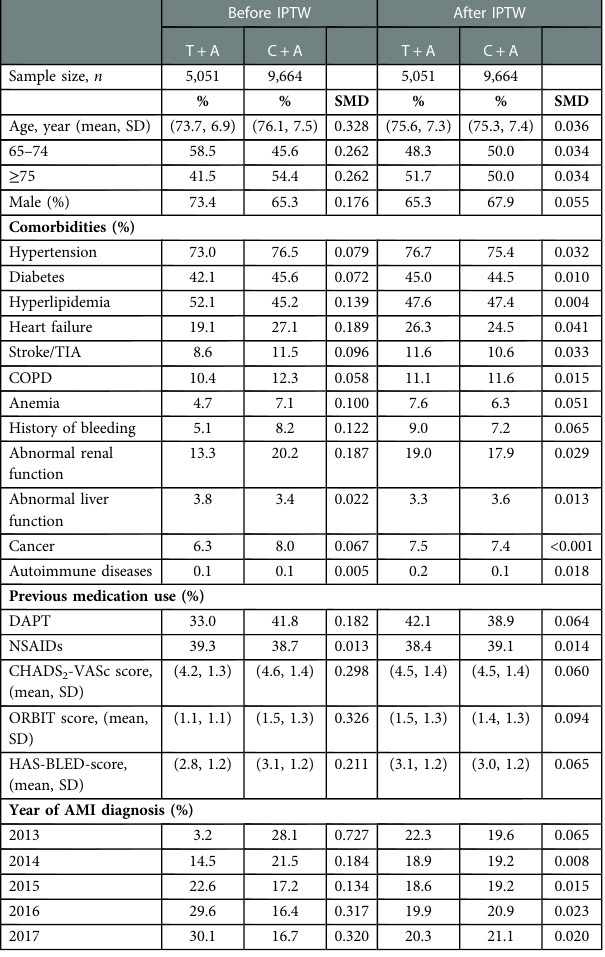
TABLE 1 Baseline characteristics of the elderly AMI patients who received aspirin with ticagrelor or clopidogrel before and after IPTW. Before